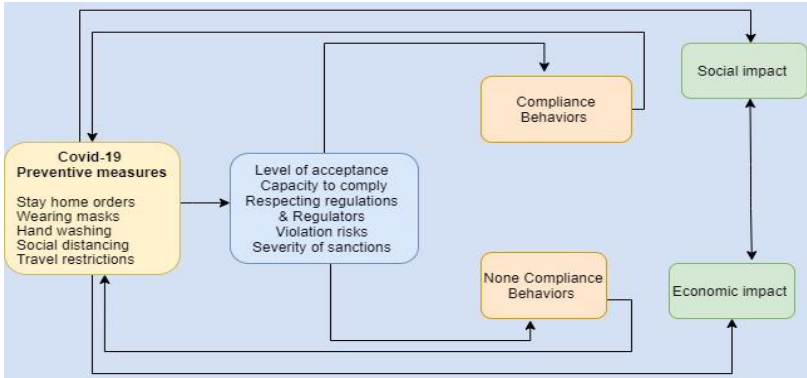
Figure 2: Community level of compliance to Covid-19 preventive